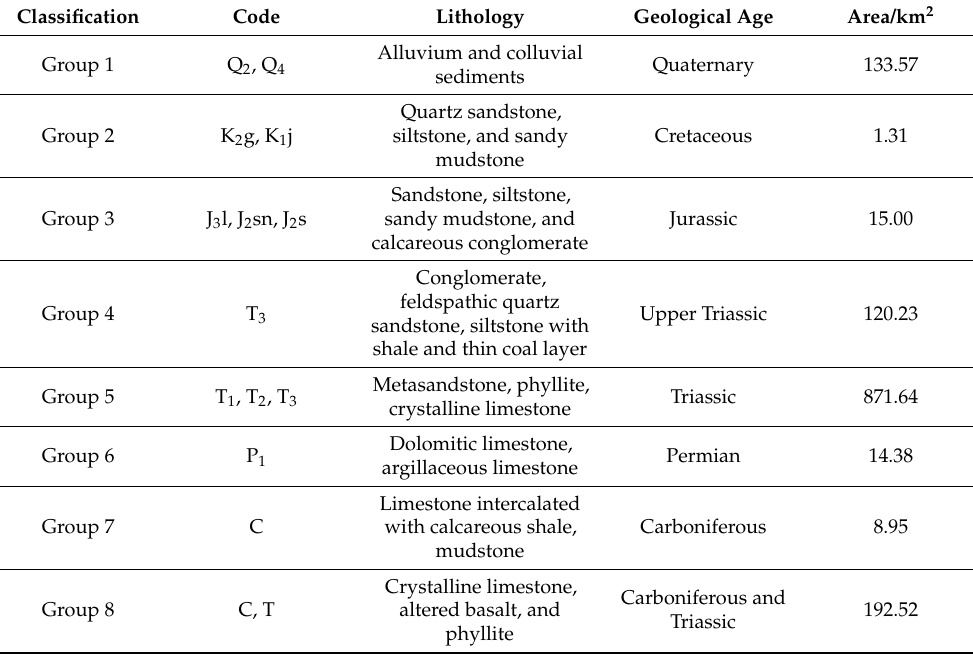
Table 2. Classification and description of the geological units in the study